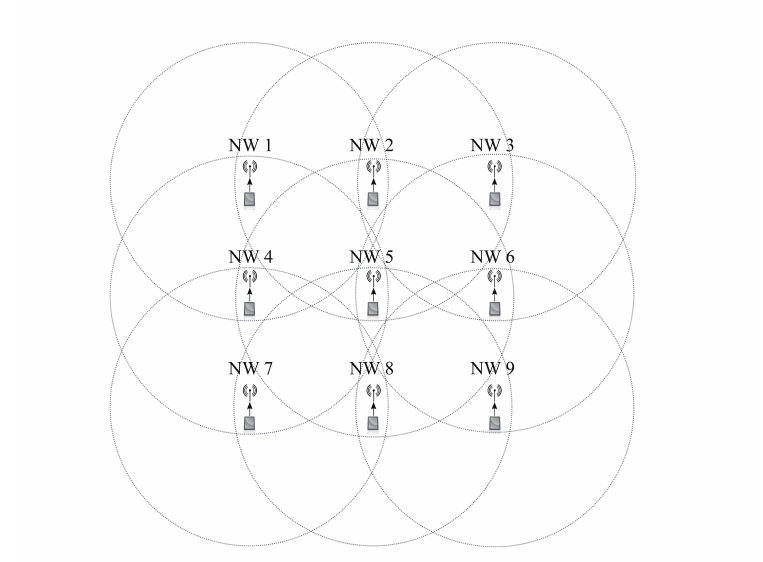
Figure 4. Carrier-sensing range of each network in